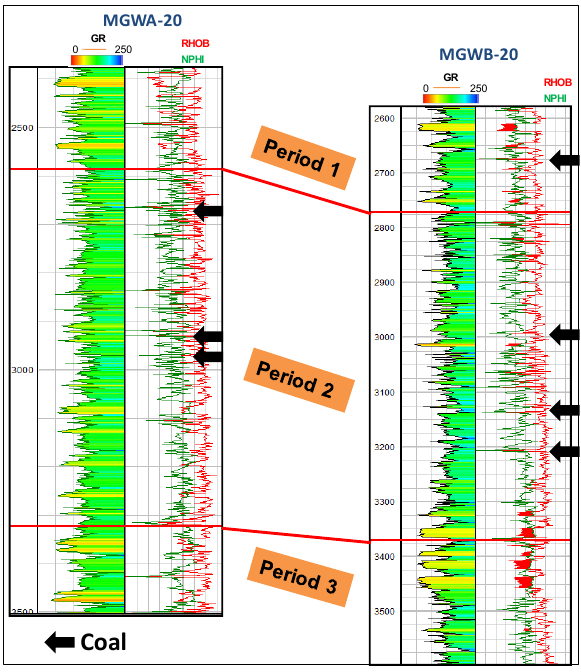
Figure 12: Wire line character of depositional sequences of period 2 3.3.3 Period 3 (K to O)